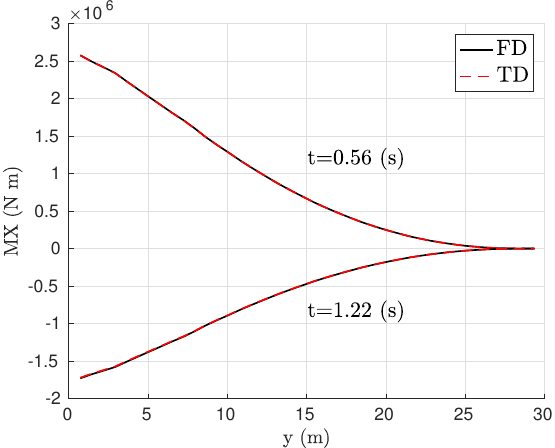
Figure 14. Incremental bending moment MX over the right wing component at different time instants for M ∞ = 0.85, h = 7640 (m), H = 106.68 (m) and α eq = 1 (deg). Two rigid-body modes and 16 flexible modes considered. Results obtained by the FSM with the generalized state-space model in the time domain (TD) of 231 states compared to the reference model in the frequency domain